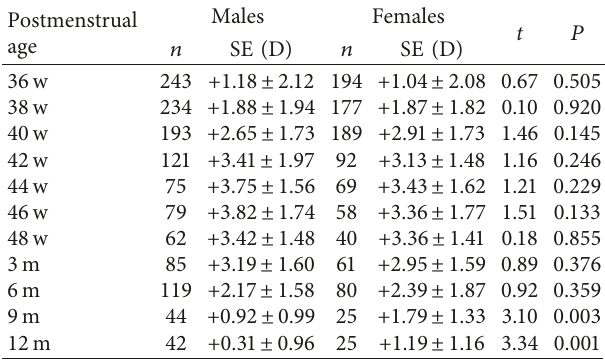
Table 4: SE of different